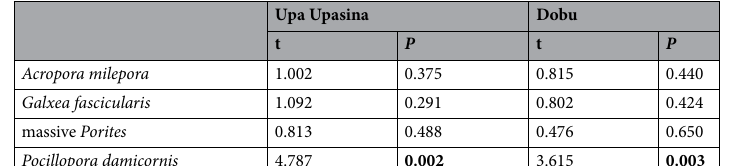
Upa Upasina Dobu P